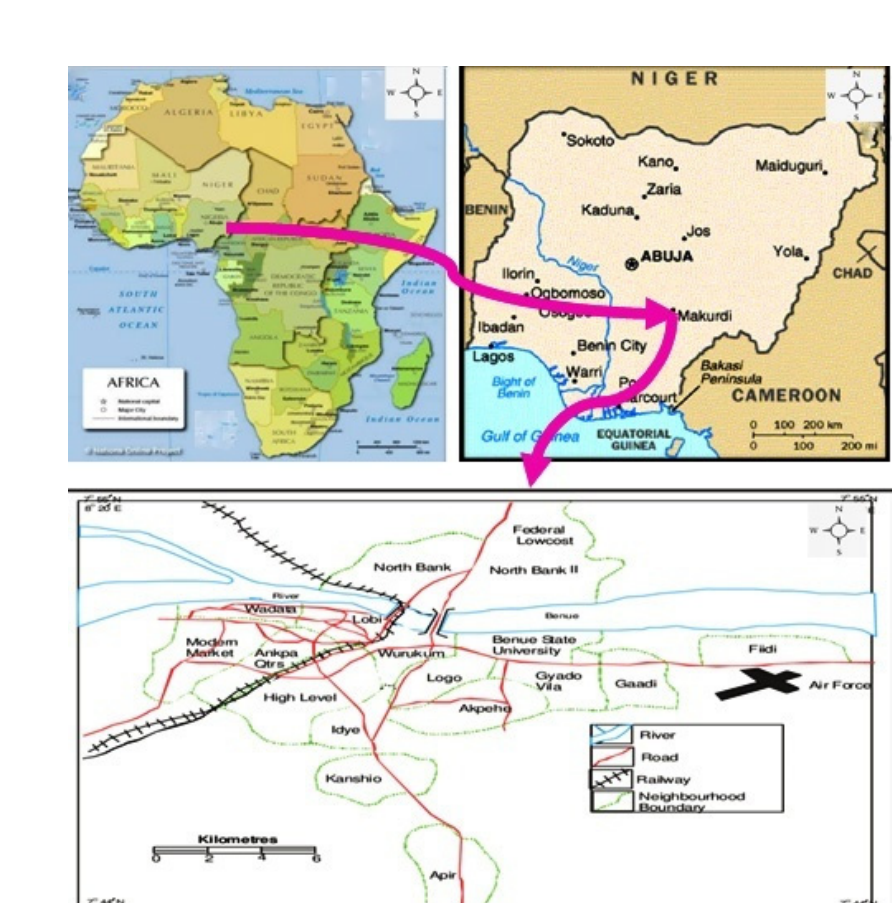
Fig. 1: The geographic location of the study area in Makurdi City, Benue State, Nigeria